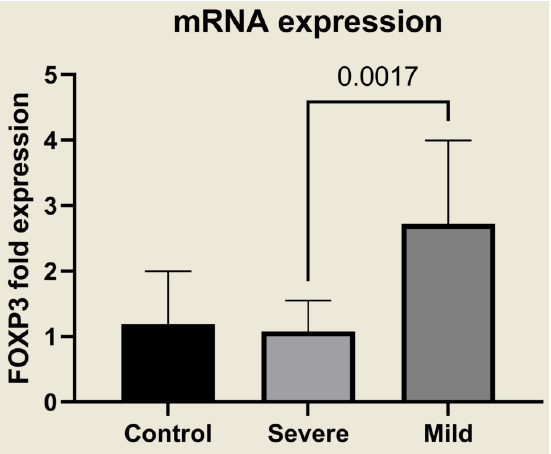
Figure 2. FOXP3 expression in malaria patients. mRNA extracted from PBMCs was tested for FOXP3 with a Qrt-PCR assay in mild and severe cases of malaria.